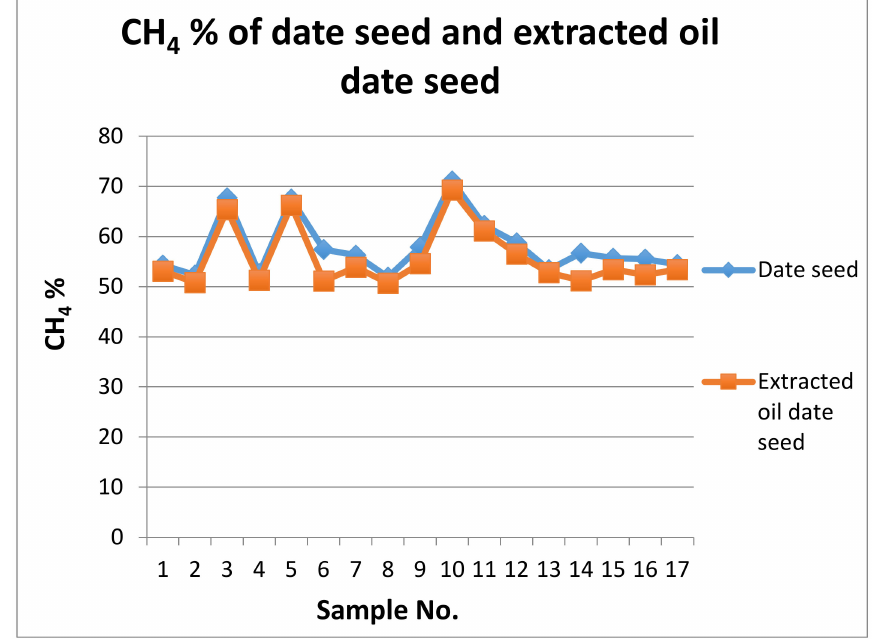
Figure 40. CH 4 % of date seed and extracted oil date seed.